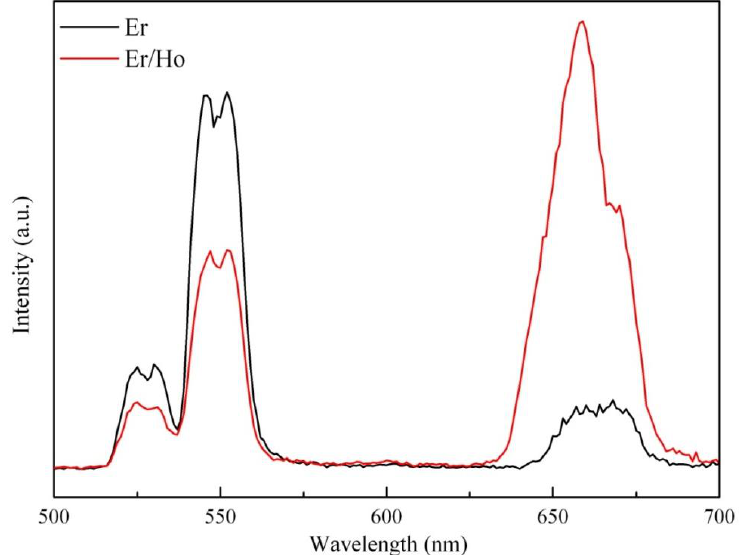
level in Er 3+ singly and Er 3+ /Ho 3+ - 13/2